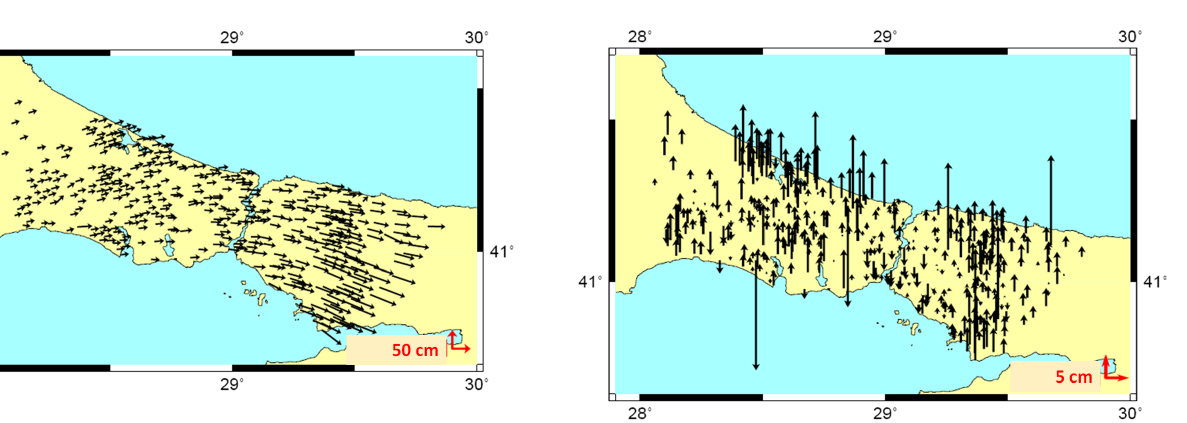
Fig. 5. Horizontal displacements of stations, estimated relative to the ANKR station (created using the GMT software) using GPS observations conducted within the IGNA network in 1999 and 2005.